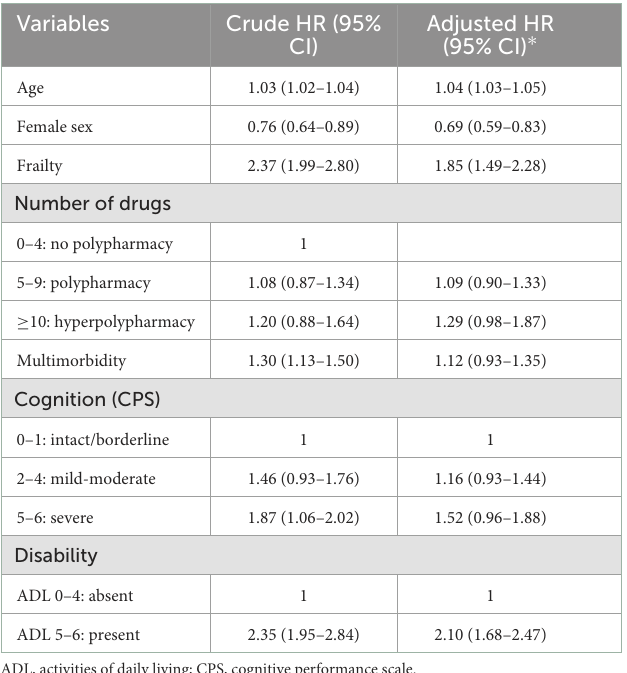
TABLE 2 Factors associated with mortality during 1-year follow-up ( n =